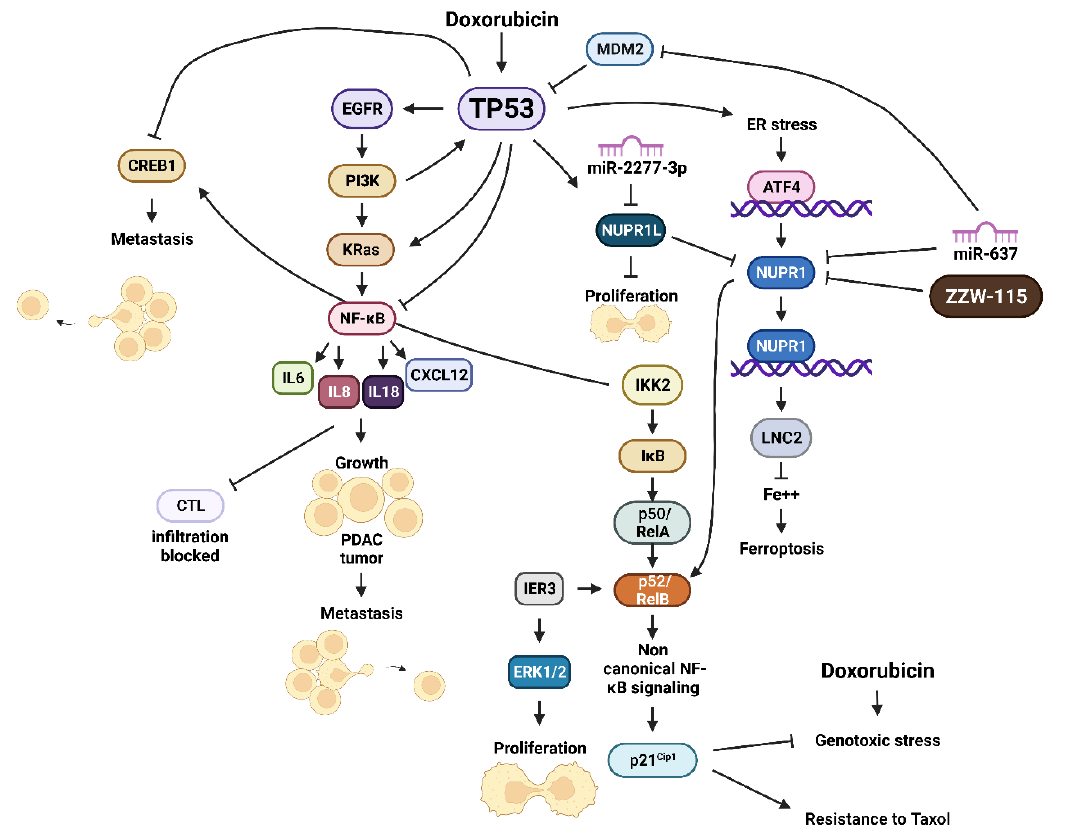
Figure 6. Effects of TP53 Signaling Pathways and Cellular Stress and NUPR1 and NUPR1L Expres- sion. Cyclic AMP response element binding protein1 (CREB1), interleukin 8 (IL8), interleukin 18 (IL18), helix-loop-helix nuclear protein 1 (NUPR1), NUPR1 ligand (NUPR1L), inhibitor of NF- κ B kinase-2 (IKK2), inhibitor of NF- κ B (I κ B), p50 NF- κ B/RelA one NF- κ B related proteins, v-Rel avian reticuloendotheliosis viral oncogene homolog B (p50/RelA), ATF4 = activating transcription factor 4 (ATF4), lipocalin 2 (LNC2), small molecule inhibitor of NUPR1 (ZZW-115).